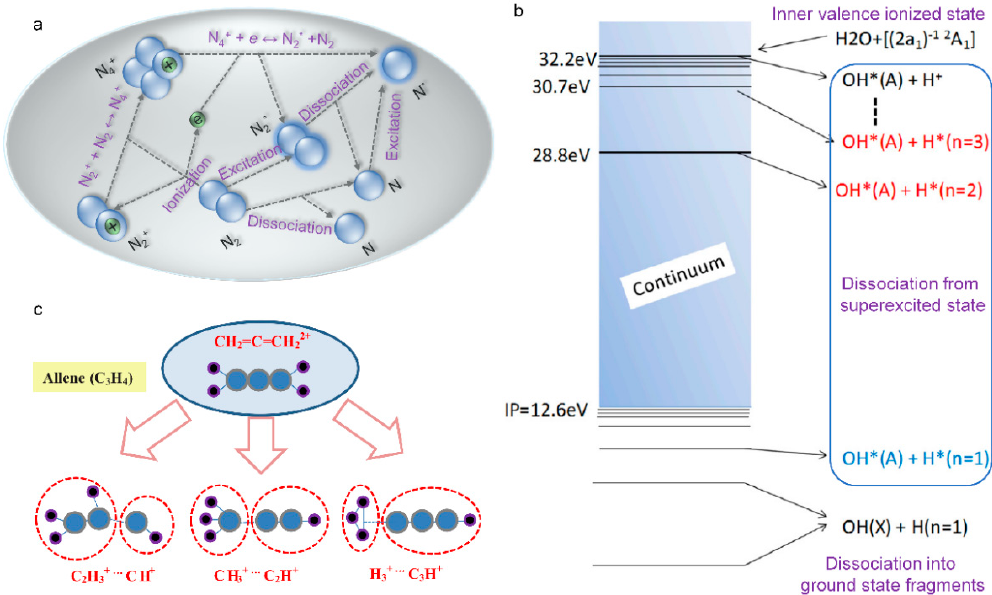
Figure 17. Schematic diagram of the dissociation of N 2 ( a ), H 2 O ( b ) [255], and allene ( c ) [14] in atmosphere. IP: ionization potential.